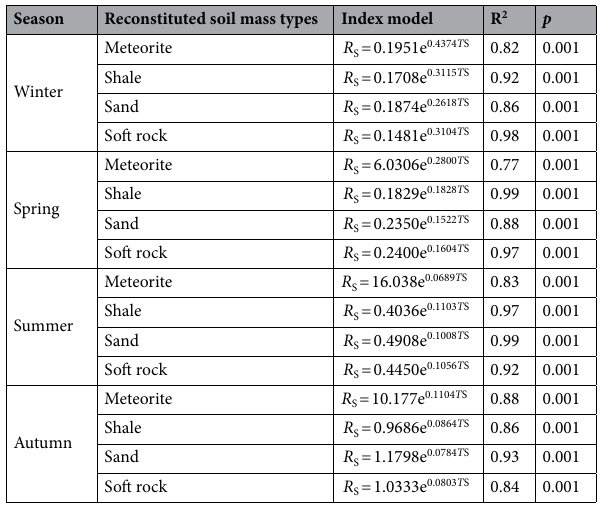
Table 2. Relationship between soil respiration rate and temperature for reconstituted soils.